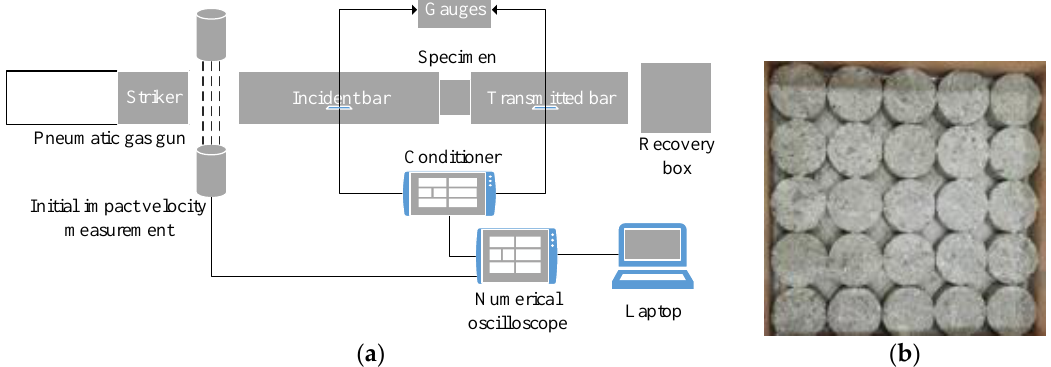
Figure 2. Split Hopkinson pressure bar (SHPB) test system ( a ) schematic diagram of SHPB test system, ( b ) specimen.